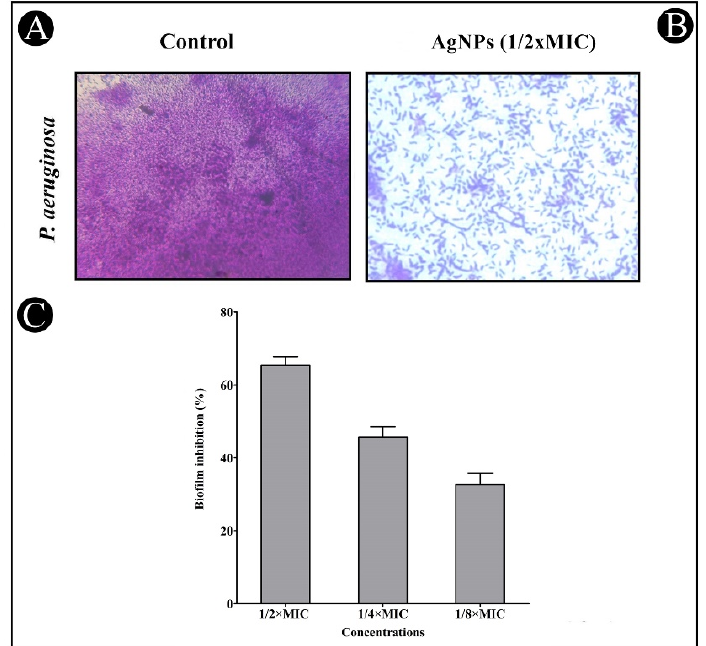
Figure 10. In situ light microscopy showed biofilm inhibition of the synthesized AgNPs against P. aeruginosa . ( A ). Control shows biofilm formation. ( B ). The synthesized AgNPs reduced the biofilm matrix at a concentration of 1/2 MIC. ( C ). The inhibition of biofilm is presented as percentage inhibition (with respect to untreated control). Values are presented as mean ± SD of three independent tests.